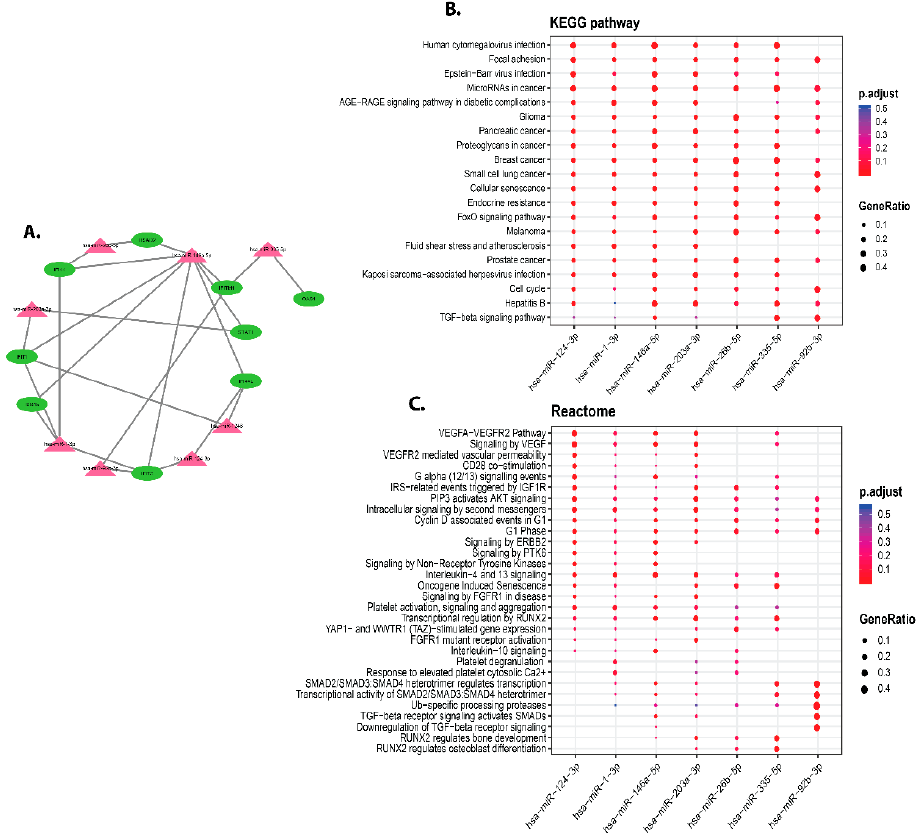
Figure 7. Hub genes and differentially expressed miRNAs are among the MIENTURNET network analysis outcomes. ( A ) MiRNA-hub genes target network visualization, with green triangular circles representing miRNAs and pink circles indi- cating hub genes miRNAs. ( B ) Based on the enrichment analysis target hub genes for the top ten differentially expressed miRNAs, a dot plot of functional enrichment analysis for the top ten differentially expressed miRNAs. The top 10 differ- entially expressed miRNAs were chosen for functional enrichment analysis. On the x -axis, selected miRNAs are illus- trated, while KEGG pathways results are shown on the y -axis. The size of the dots reflects the gene ratio, and the colour of the dots indicates the adjusted p -value (FDR) (number of miRNA targets found enriched in each category over the number of total genes associated with that category). ( C ) The pathways of the reactome.